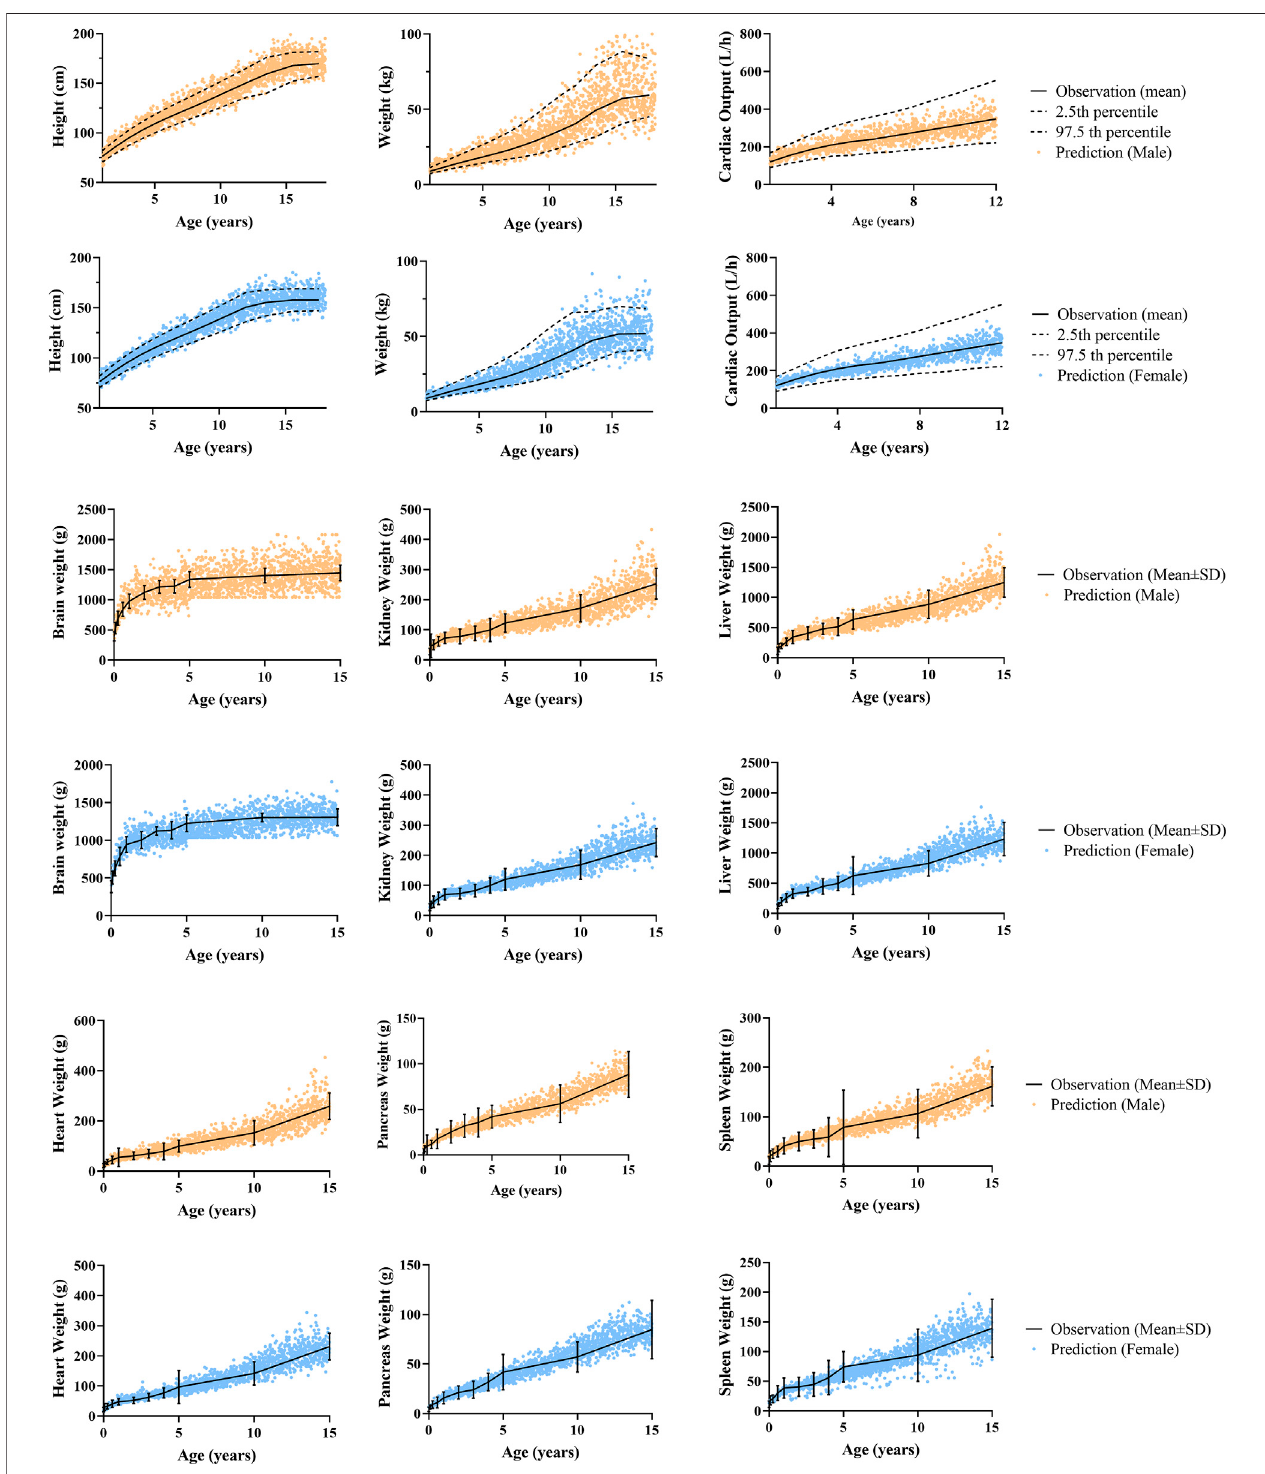
FIGURE 3 | Predicted and observed physiological data in male and female. Anthropometric data (height, weight) and cardiac output data aged from 1 to 12 years old were reported by Cattermole et al. (2017), and anthropometric data aged from 13 to 18 years old were from the National Physique and Health Database (http:// cnphd.bmicc.cn/chs/en/index.php). Organ weight data aged from 0 to 15 years old were reported by Wang at al. (1995a).